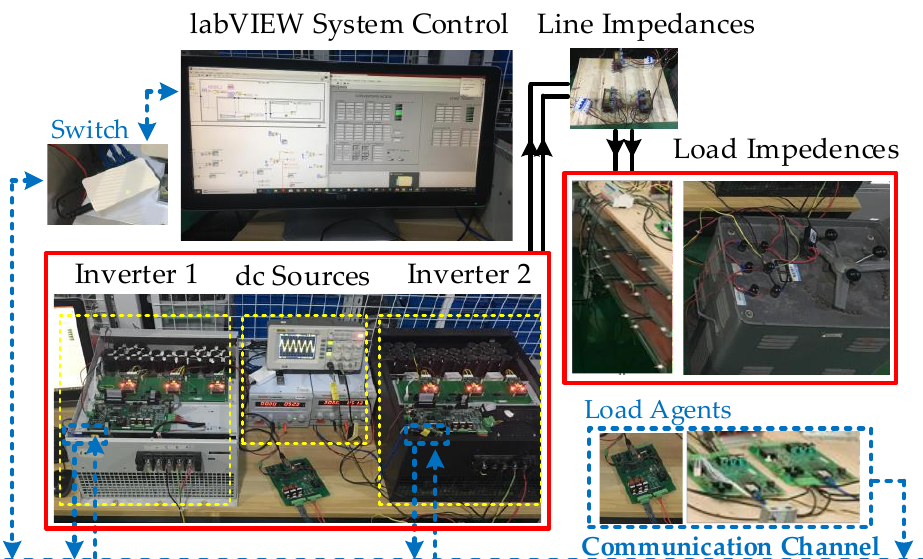
Figure 6. Live laboratory experimental prototype.